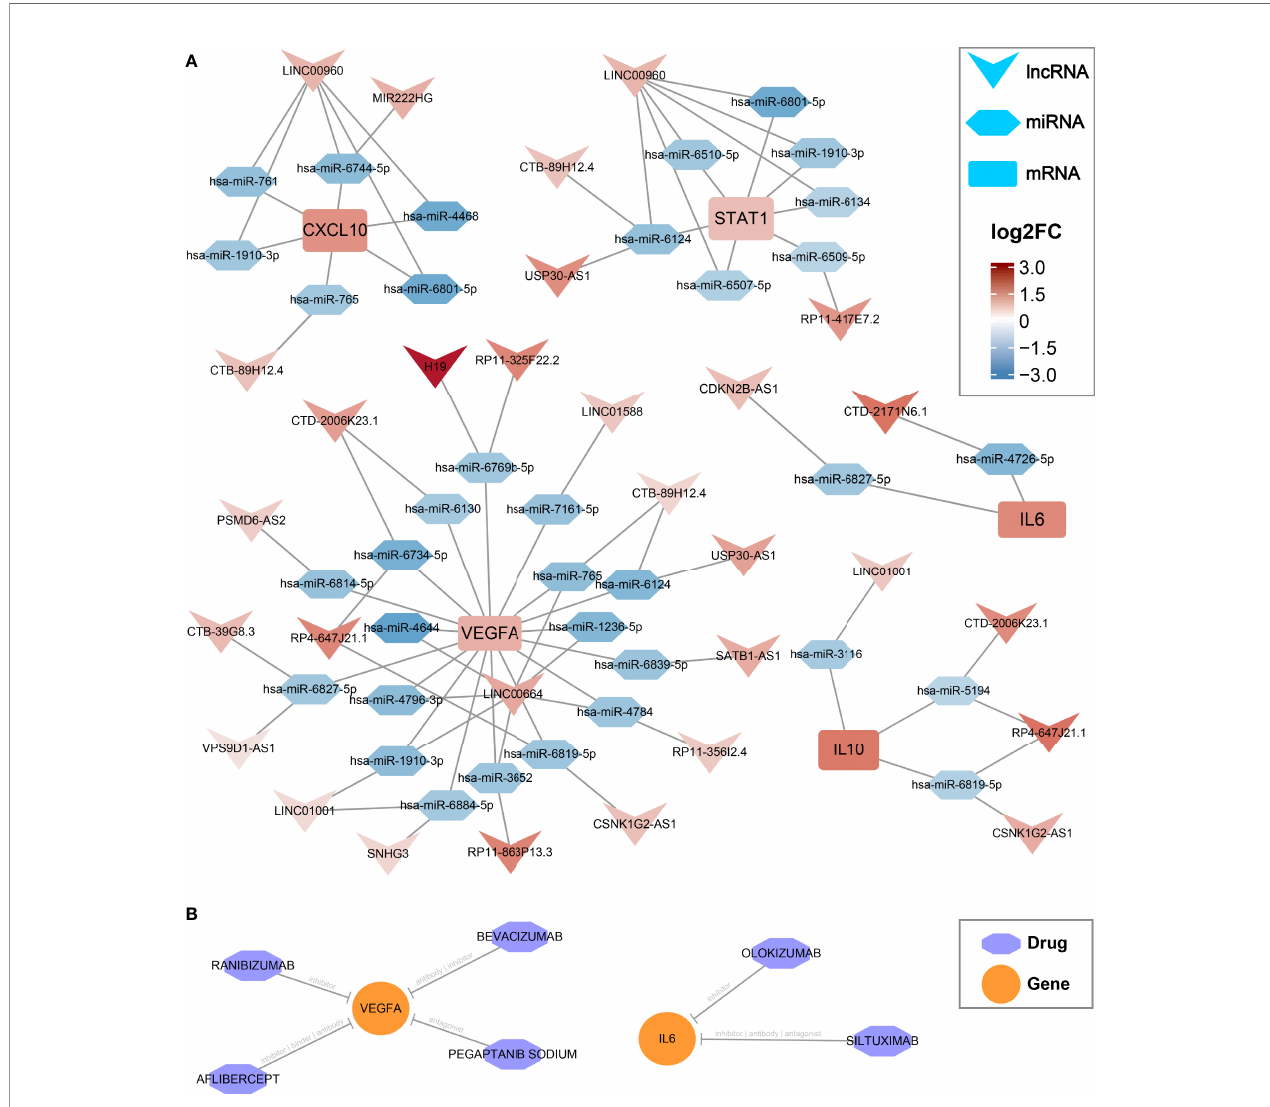
FIGURE 4 | CeRNA regulatory networks and latent drugs targeting the hub genes. (A) ceRNA networks of CXCL10, IL6, IL10, STAT1, and VEGFA. Log2FC, log2 (foldchange). (B) drug-gene interaction predicted via DGIdb